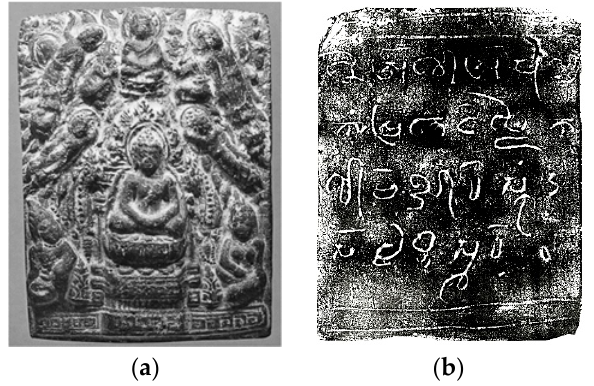
Figure 5. The Ś r ā vast ī miracles (Buddha meditating on the lotus throne, mango tree, and multiplied Figure 5. The Śrāvastī miracles (Buddha meditating on the lotus throne, mango tree, and multiplied Buddhas) with an ancient Mon with Khmer loan words inscription (Southern Brahm ī script). Ca. Buddhas) with an ancient Mon with Khmer loan words inscription (Southern Brahmī script). ( b ) Back Side. After Dhamrungrueng (2015 [2558 BE], fig. 14).